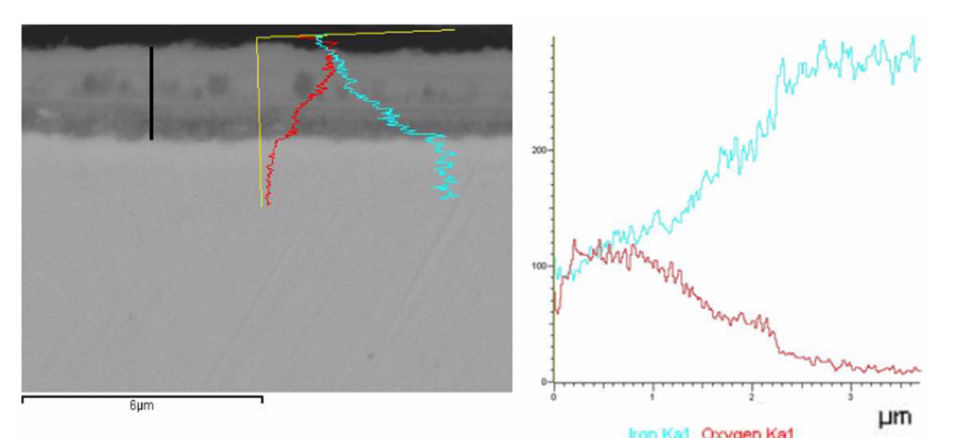
Figure 4. Backscattered SEM picture of the corrosion layer obtained in A516 at 1000 h ( left ) and concentration profile of Fe and O ( right ).